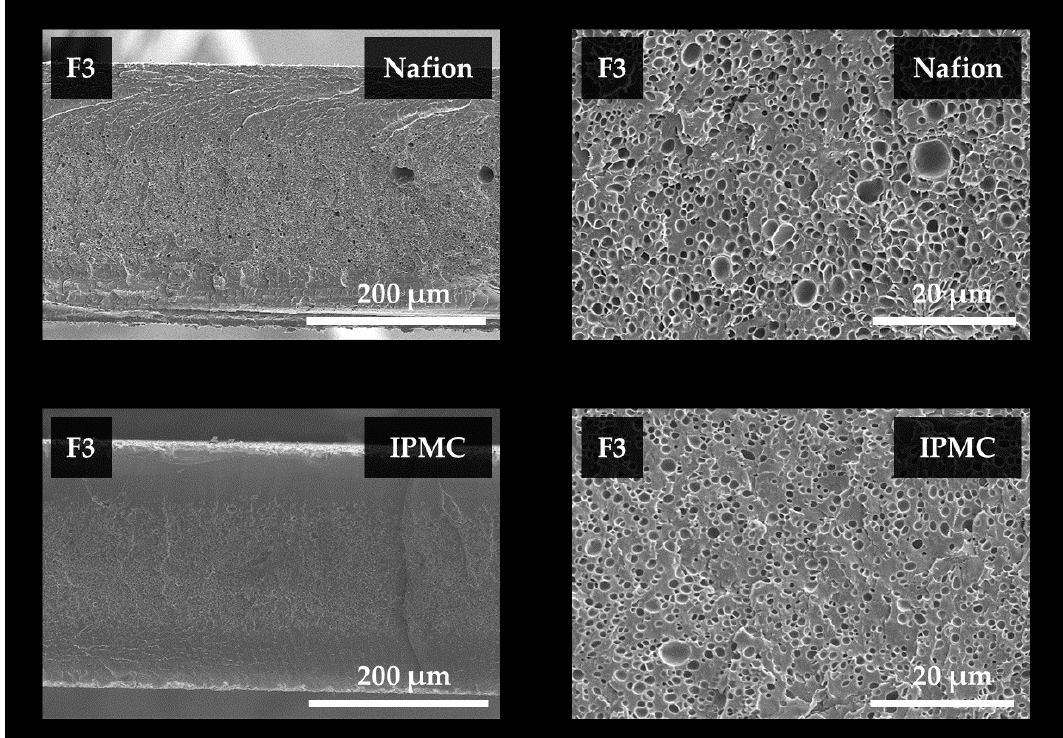
Figure 11. Scanning electron microscope observation image of the cross section of Nafion and IPMC specimens, according to the F3 foaming condition.